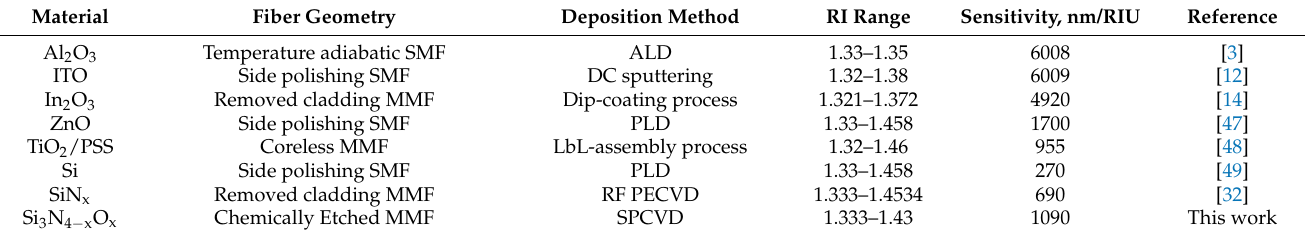
Table 2. Sensitivity of different types of sensors, depending on the composition of the coating.